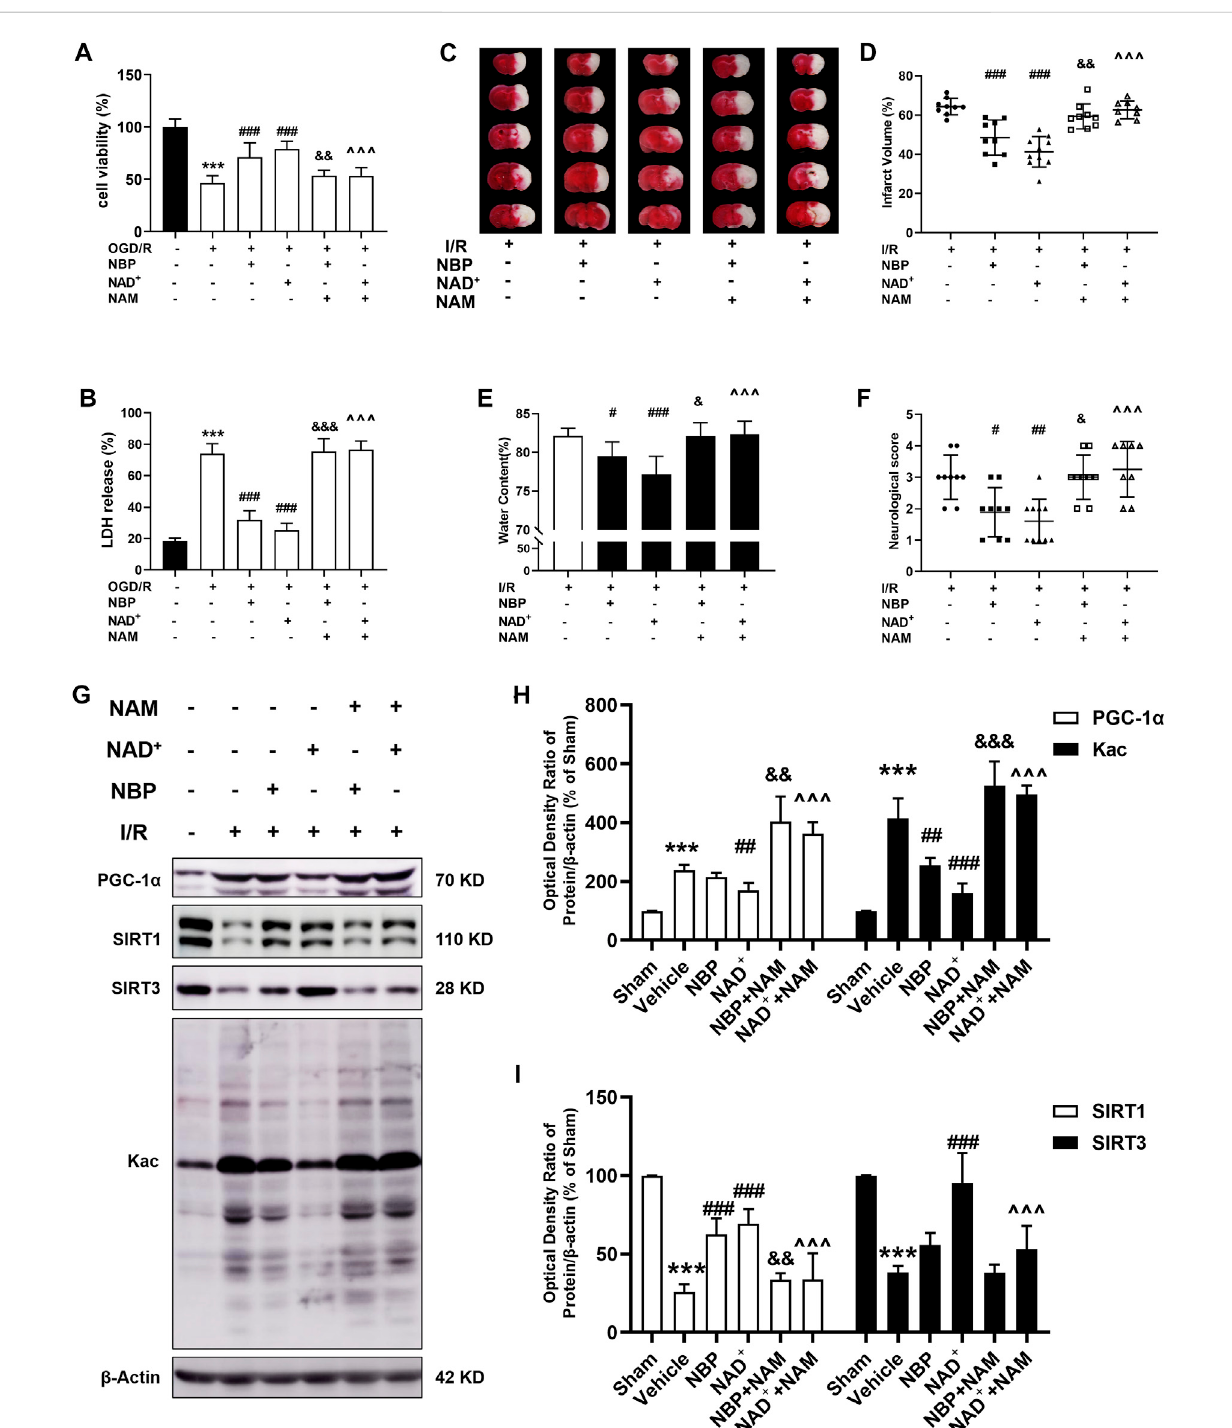
FIGURE 7 EffectsofsirtuininhibitorontheprotectionofNAD + andNBPincerebralischemia. (A,B) Primarycorticalneuronsweretreatedwith10 mMNAMfor 4 h. Glucose and hypoxia were next taken away from the primary cortical neurons for 4 h, and then 15 mM NAD + or 5 μ M NBP were administered transiently after reperfusion. After 24 h of reperfusion, the viability and toxicity of the cells was determined using the CCK-8 kit and LDH assay kit. (A) Cell viability in each group. (B) Cell toxicity in each group. n = 6 per group. (C – F) In mice, NAM (100 mg/kg) were administrated 2 h before tMCAO. tMCAO was next performed for 2 h, and then NBP (30 mg/kg) or NAD + (50 mg/kg) were administrated to mice immediately after reperfusion. tMCAO/ R-treatedmiceweresacri fi ced24 haftertheprocedure. (C,D) TTCstainingwasusedtomeasurethecerebralinfarctvolume. (E) Thebrainwatercontent at 24 h after reperfusion. (F) The neurological de fi cit score at 24 h after reperfusion. (G – H) Analysis of PGC-1 α and Kac expression in ischemic cortex. (I) Analysis of SIRT1 and SIRT3 expression in ischemic cortex. ***p < 0.001 vs. sham, # p < 0.05, # p < 0.05, ## p < 0.01 and ### p < 0.001 vs. vehicle + I/R or vehicle + OGD/R, & p < 0.05, && p < 0.01 and &&& p < 0.001vs. NBP, ^^^ p < 0.001vs. NAD + by One-way analysis of ANOVA followed by Tukey ’ s multiple comparisons test. Data were expressed as the mean ± SD. There were at least six animals or three independent cultures in each